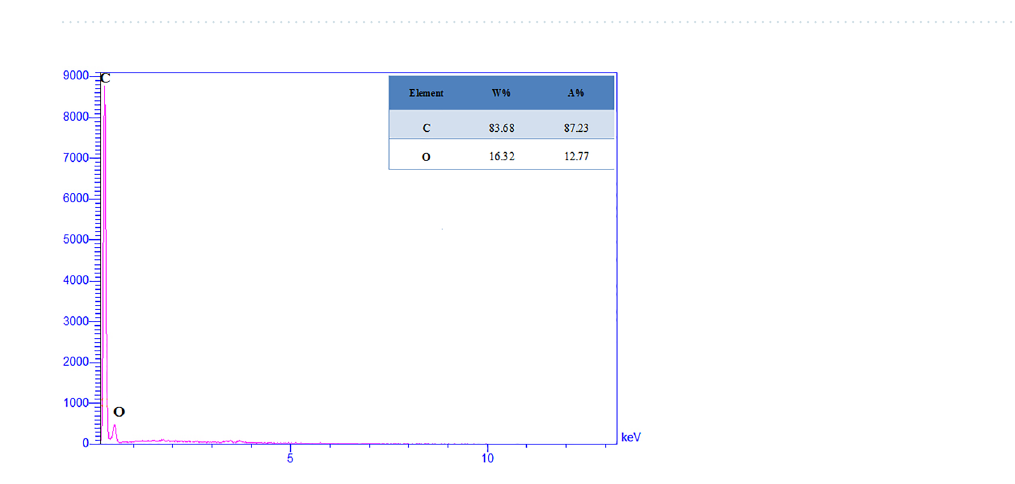
Figure 3. TEM images showing the representative microstructures of carbonized fibers at ( a ) 1000 °C, and ( b ) 1400 °C.